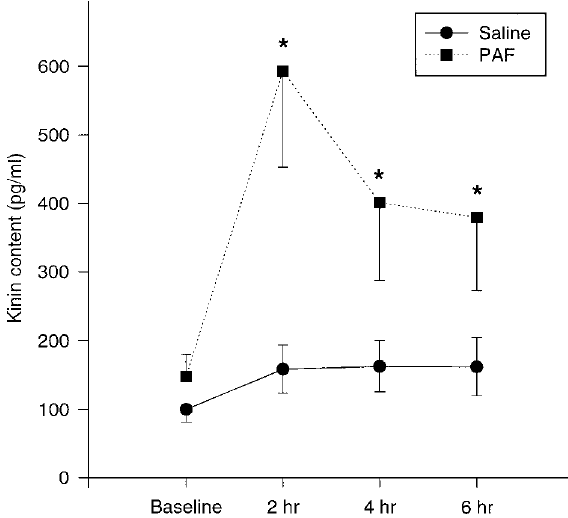
FIG. 6. The effect of PAF on the concentration of kinins in nasal lavage fluid. The nasal airway was challenged with either saline or PAF, 60 m g, and the airway was lavaged 2, 4 and 6h after challenge. Data are means± SEM from 13 subjects. *Significant increase ( P <0.05) in levels of kinin following challenge with PAF compared to saline (Wilcoxon sign-rank